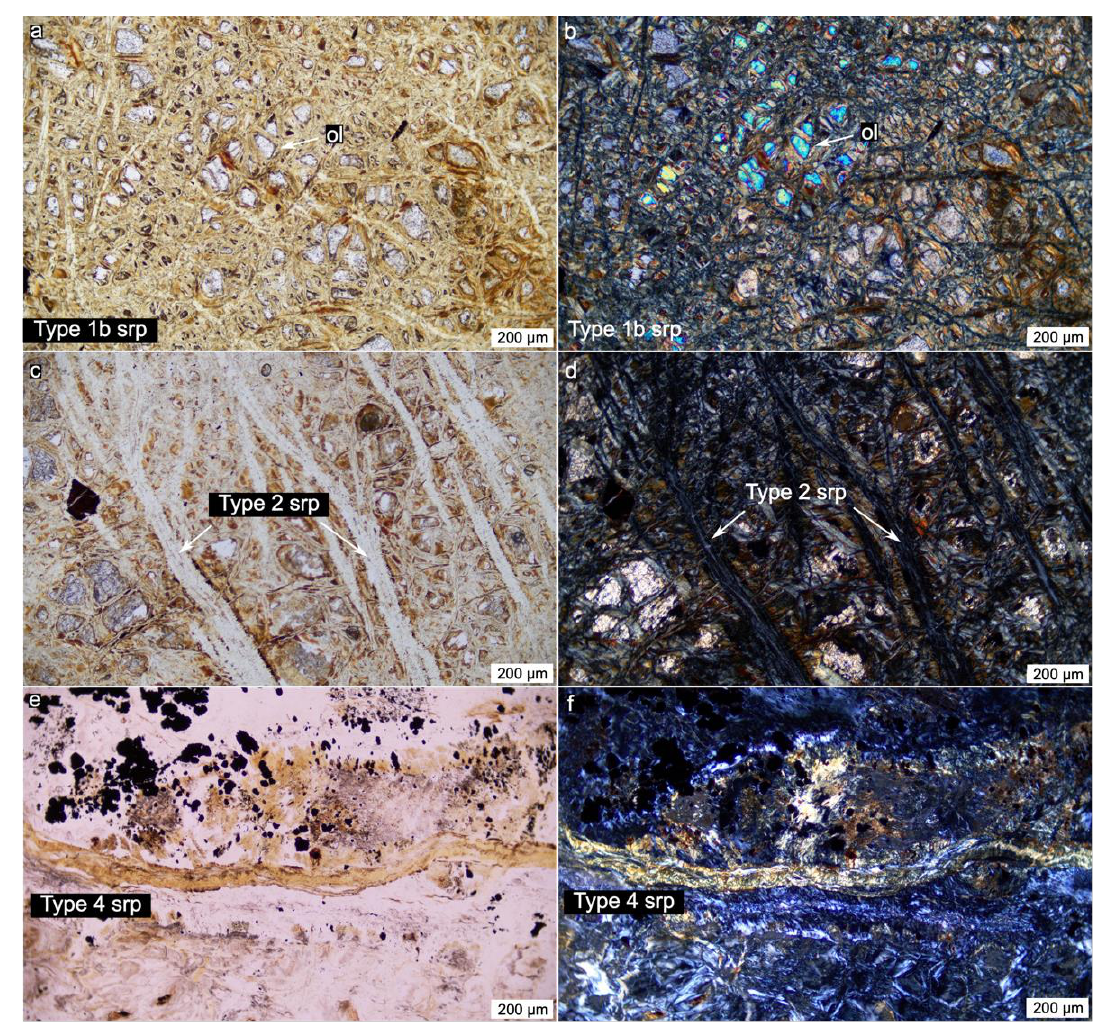
Figure 5. Thin section of samples from the lower saprolite. ( a ) Sample N-750 is strongly serpentinized and contains a significant amount of primary olivine fragments in optical continuity. Note the brown discoloration on some of the type 1b serpentines, likely due to the presence of Fe-oxide. ( b ) Same as ( a ) in crossed-polarized transmitted light. ( c ) N-900 showing roughly parallel serpentine veins (type 2 serpentine) free from Fe-oxide discoloration. Further shown are partially dissolved relict olivine grains. ( d ) Same as ( c ) in crossed-polarized transmitted light. ( e ) Photomicrograph of type 4 serpentine crosscutting the lower saprolite in plane-polarized transmitted light. ( f ) Same as ( e ) in crossed-polarized transmitted light.